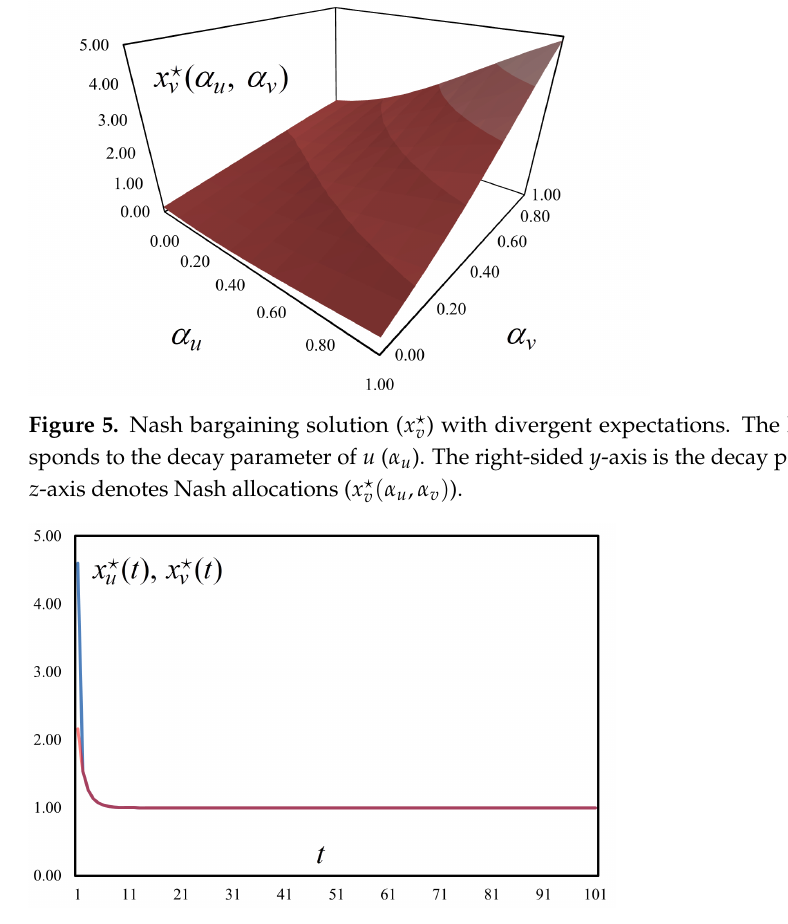
Figure 6. Convergence dynamics of Nash allocations ( x (cid:63) u , x (cid:63) v ) for α u = 0.60 and α v = 0.70. The x -axis corresponds to the timeline ( t ). The y -axis denotes the evolution of Nash allocations as a function of time ( x (cid:63) u ( t ) , x (cid:63) v ( t )